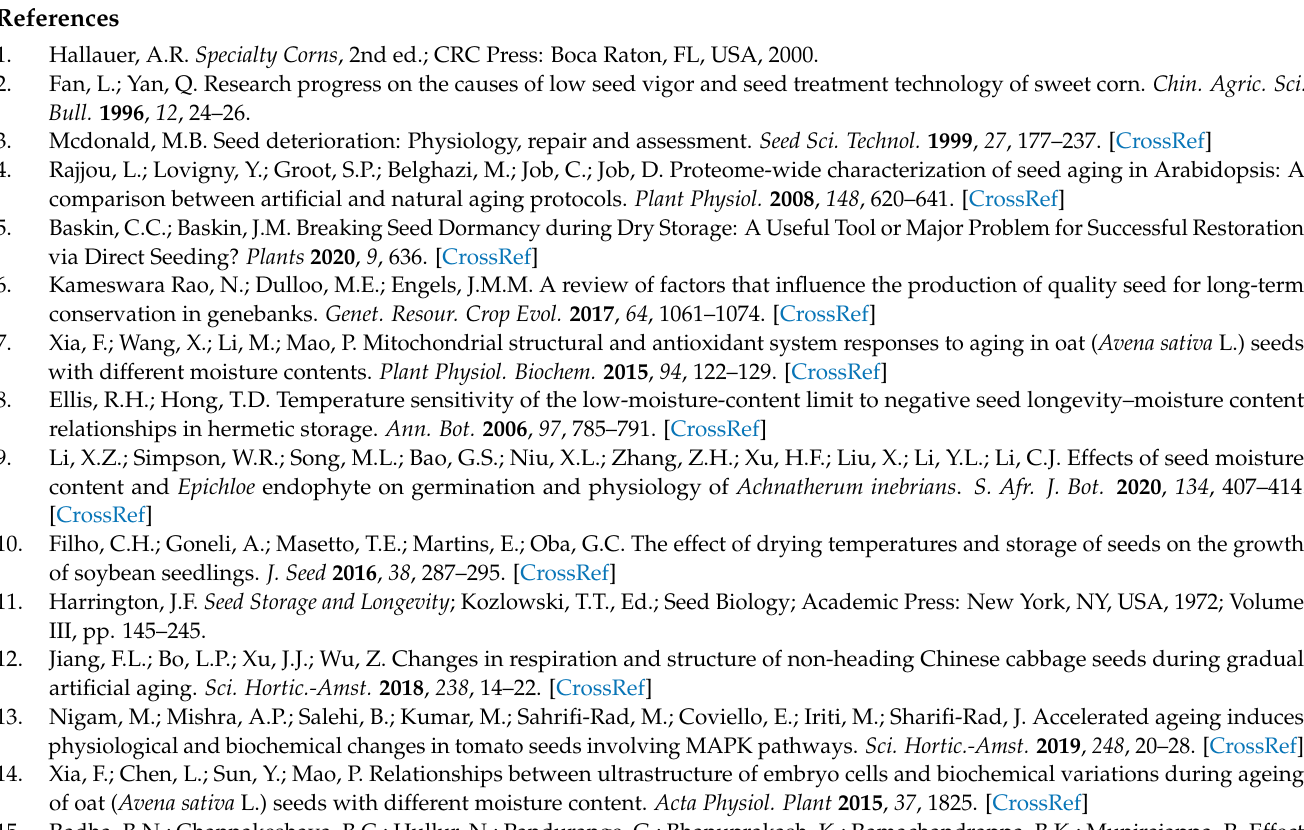
performed the experimental analyses. All authors have read and agreed to the published version of the